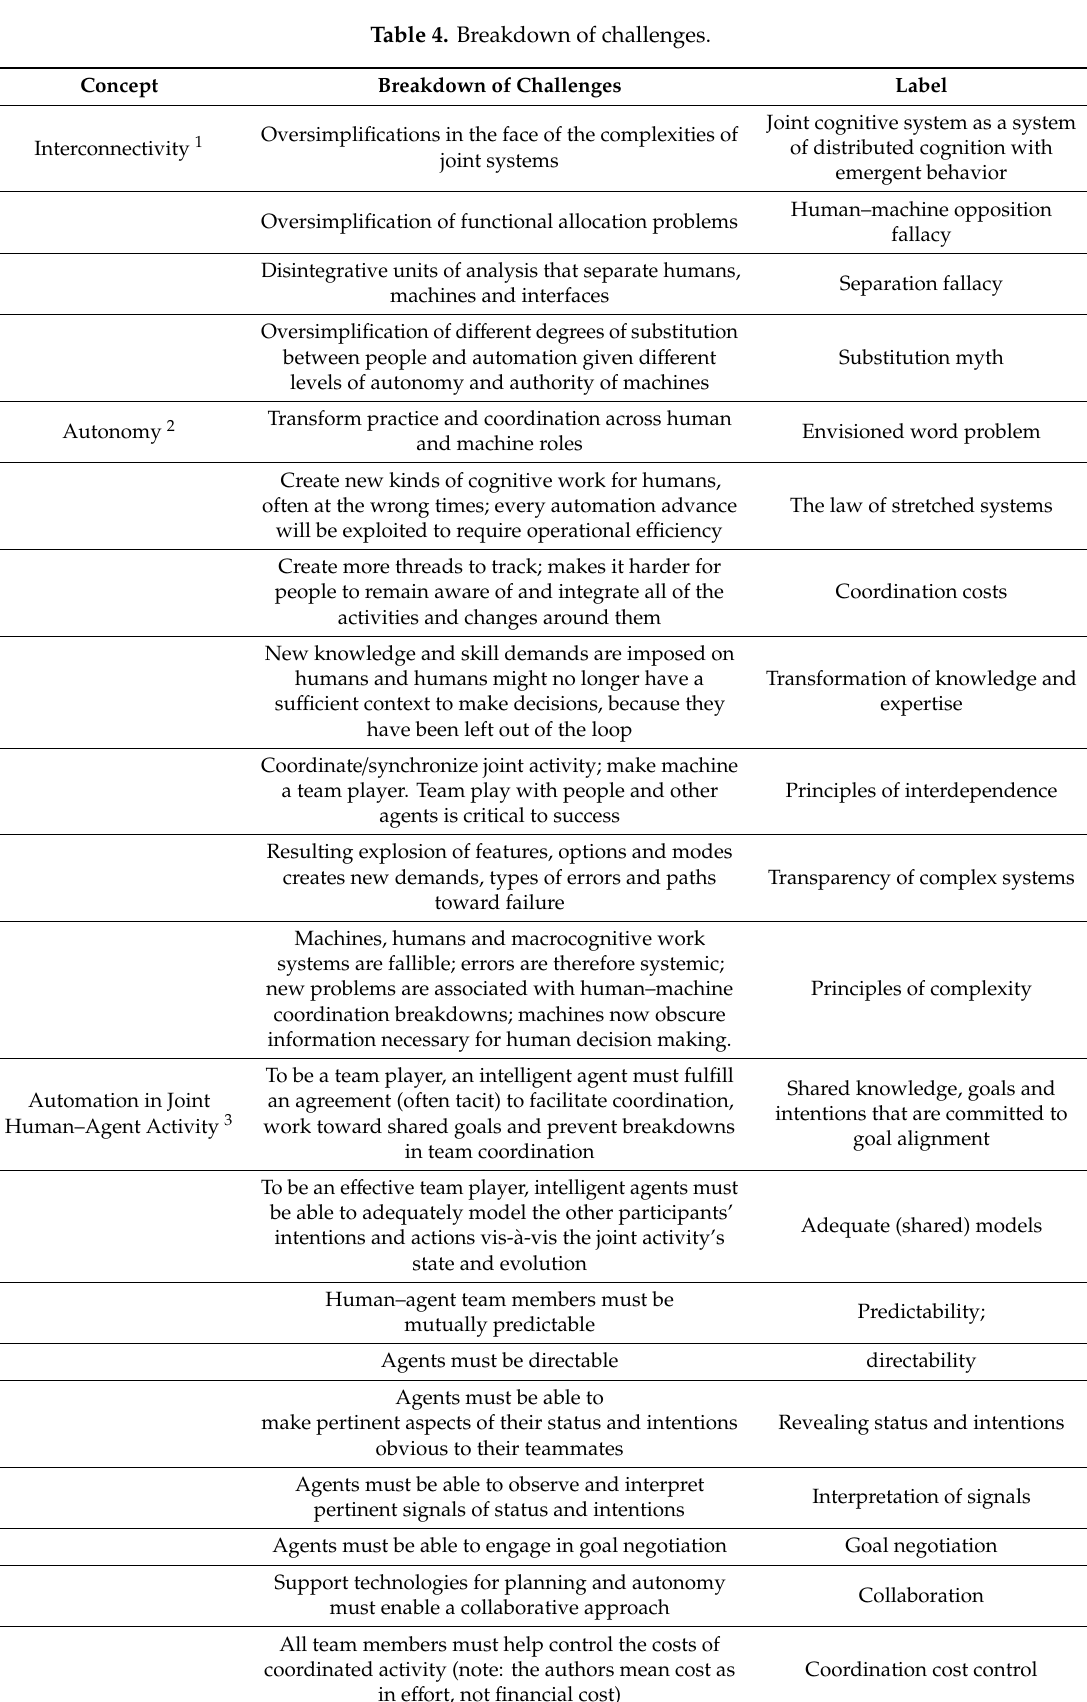
Table 4. Breakdown of